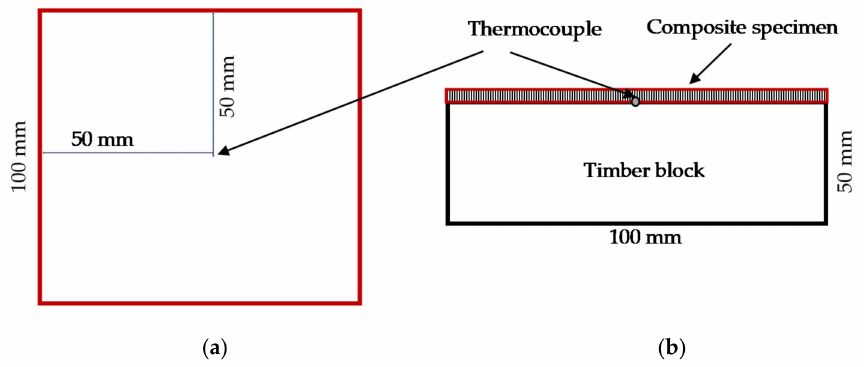
Figure 4. The set-up of test specimen: ( a ) top view of timber surface; ( b ) cross-sectional view of specimen on timber